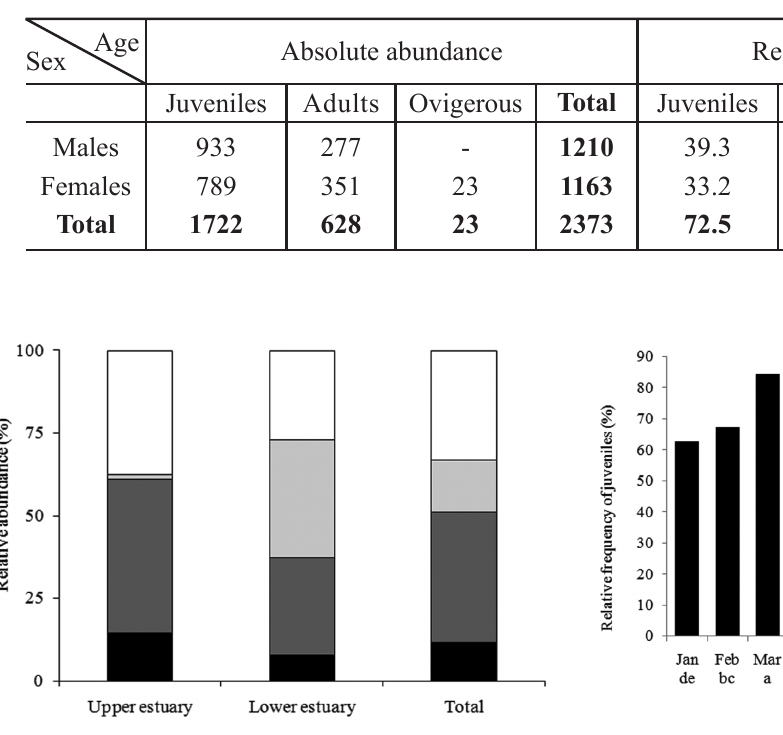
Fig. 3 – Callinectes danae . Temporal distribution of juveniles frequency at the Santa Cruz Channel. Note: months sharing at least one letter in common did not differ significantly among them (α =